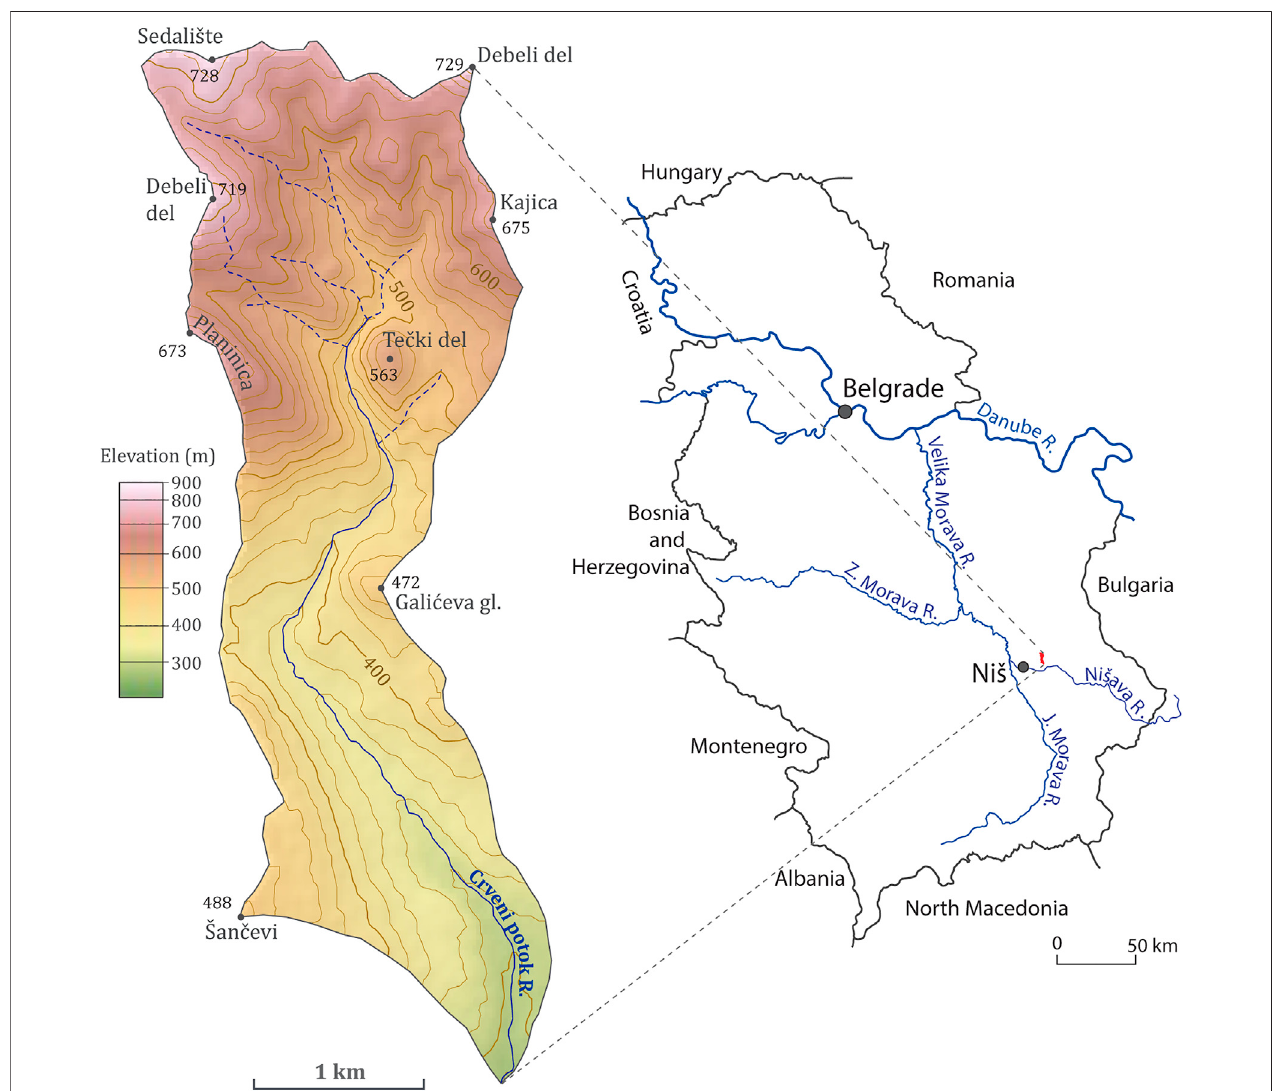
FIGURE 1 | The Crveni potok River Basin and its geographical location in